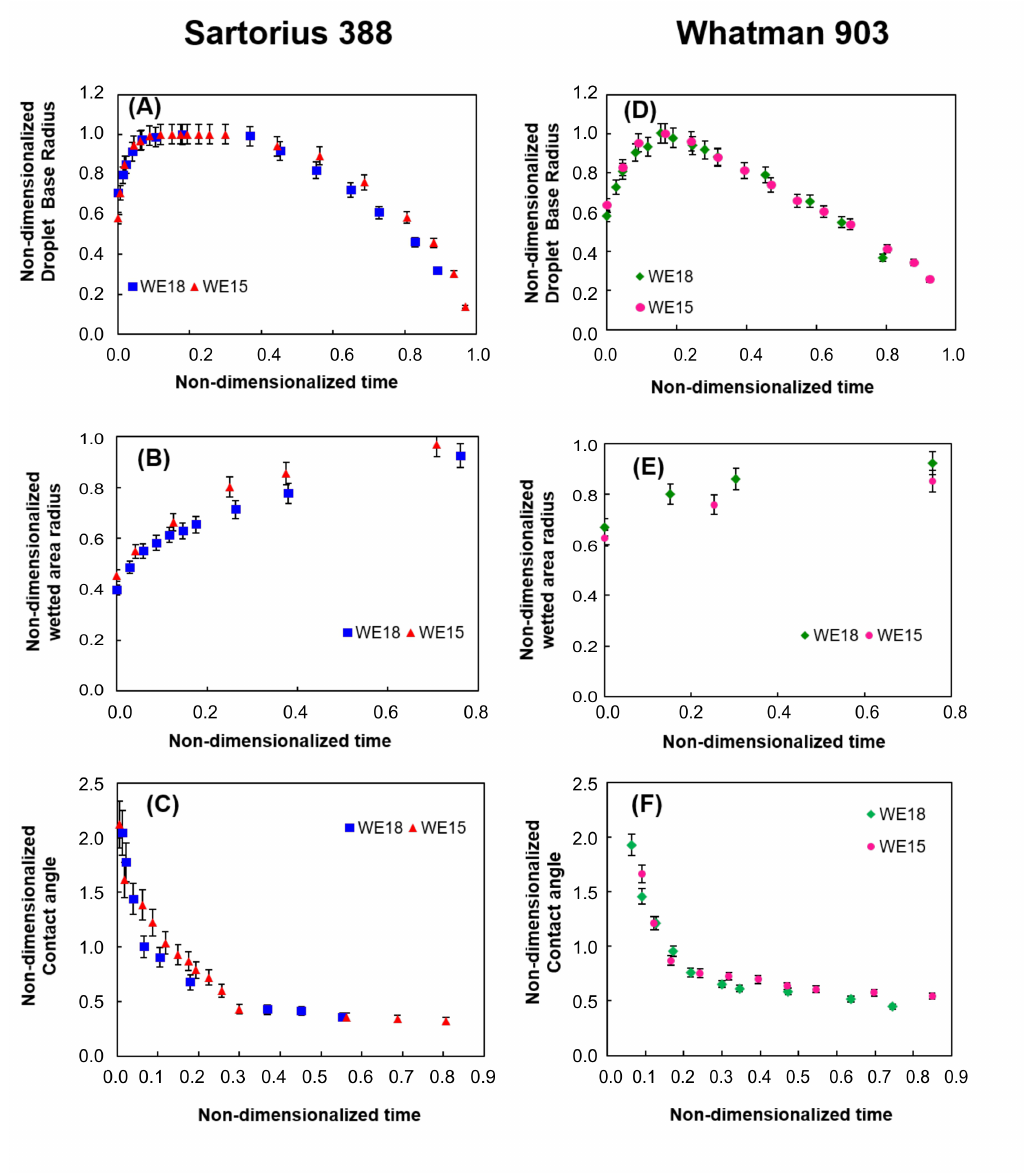
Figure 9. Evolution of the dimensionless liquid cap base radius, the dimensionless wetted area radius and the non-dimensionallzed contact angle with non-dimensionalied time for the spreading of WE18 and WE15 droplets on Sartorius 388 ( A – C ) and Whatman 903 ( D – F